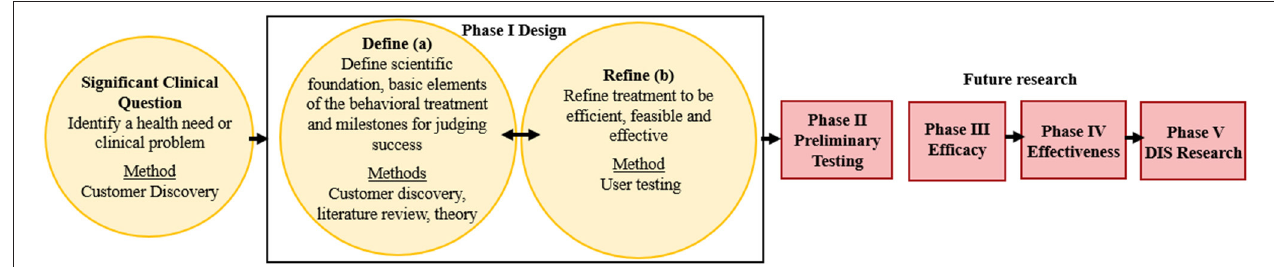
FIGURE 1 | Application of the ORBIT Model for PREVENT Tool Development. Yellow boxes indicate completed research; red boxes are future research; DIS: dissemination, implementation, and sustainability. Figure adapted from Czajkowski et al.